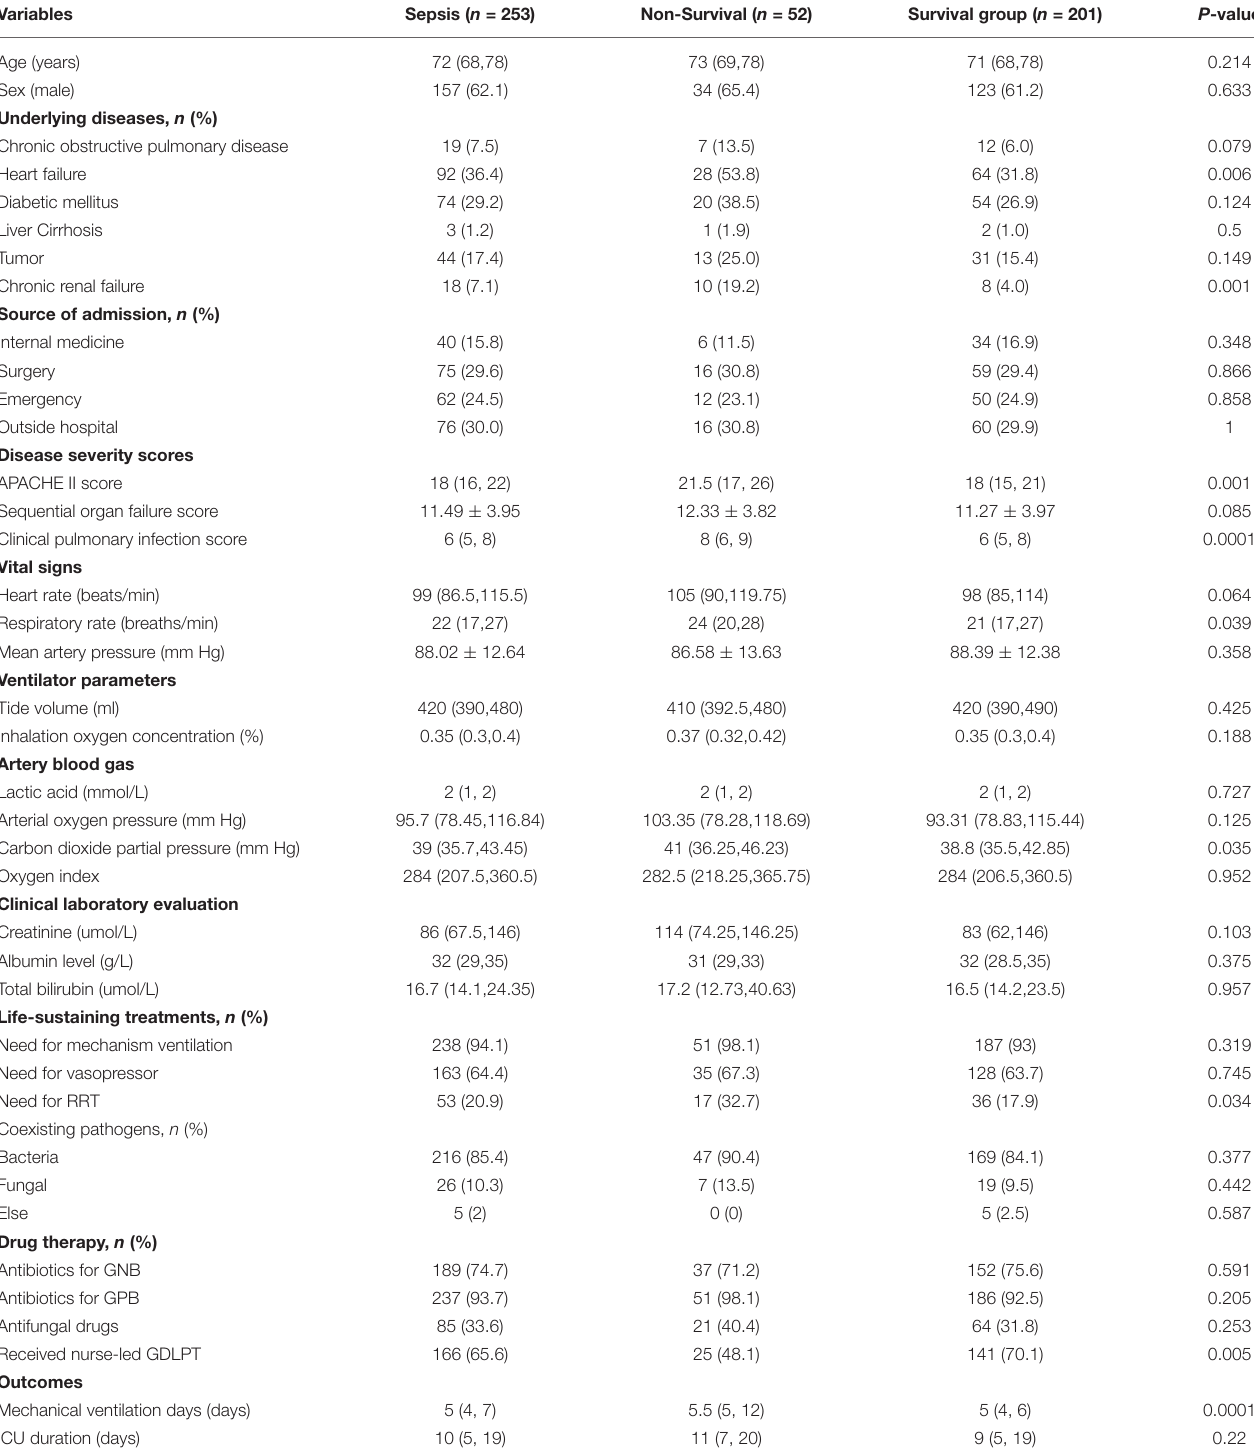
TABLE 2 | Characteristics of the study population in survivors and non-survivors according to 28 day mortality. Variables Sepsis ( n = 253) Non-Survival ( n = 52) Survival group ( n =